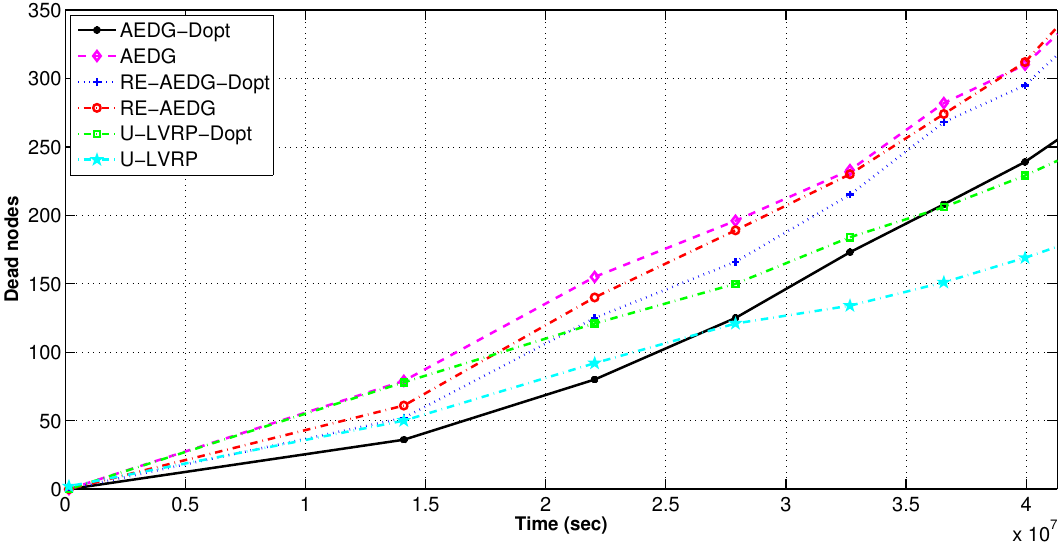
Figure 10. Death rate of nodes in delay optimized and non optimized protocols.